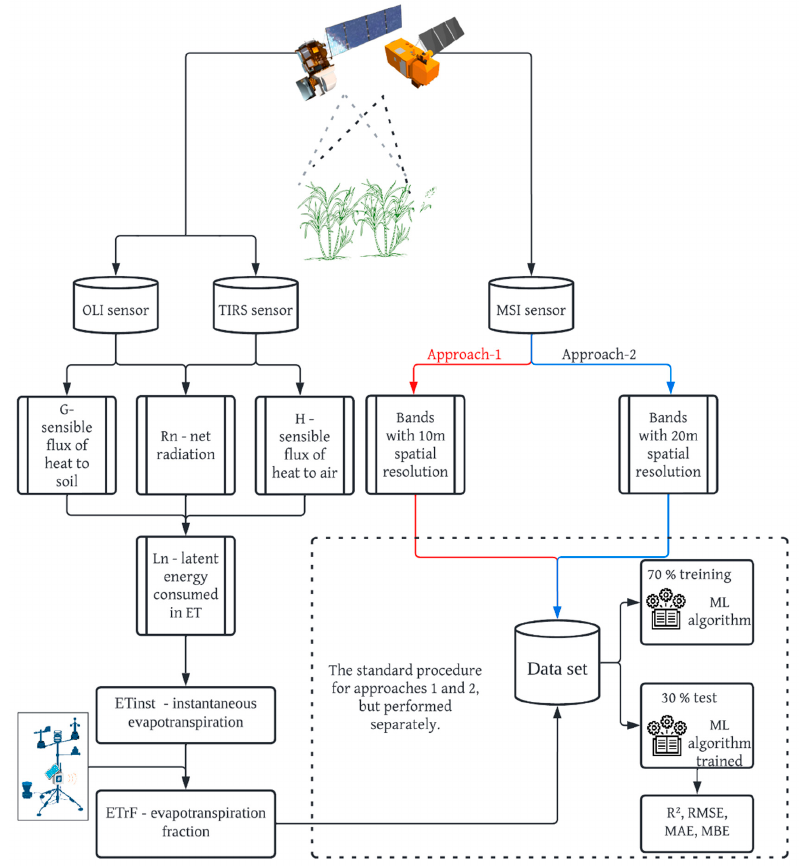
Figure 3. Acquisition of data from sensors onboard Landsat-8 and Sentinel-2 for training and testing in machine learning algorithms.